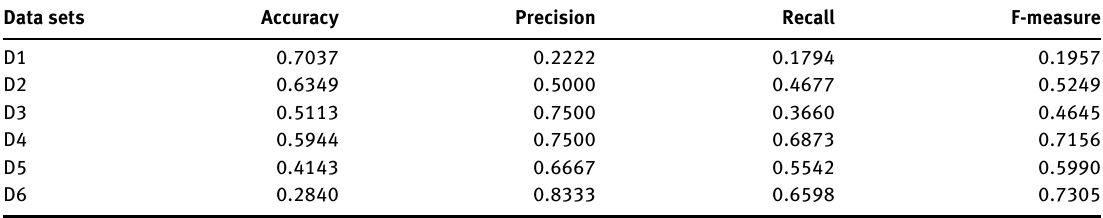
Table 3: The Evaluation Results of the TCP-GWO Arrived up to 20 Experiments on the Clustered Data Set. Data